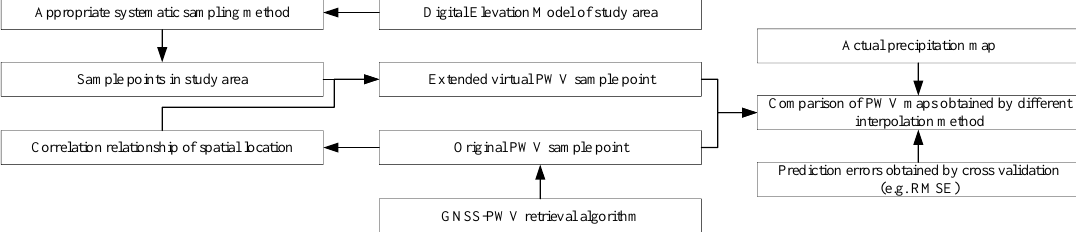
Comparison of PWV maps obtained by different interpolation method Prediction errors obtained by cross validation (e.g. RMSE)